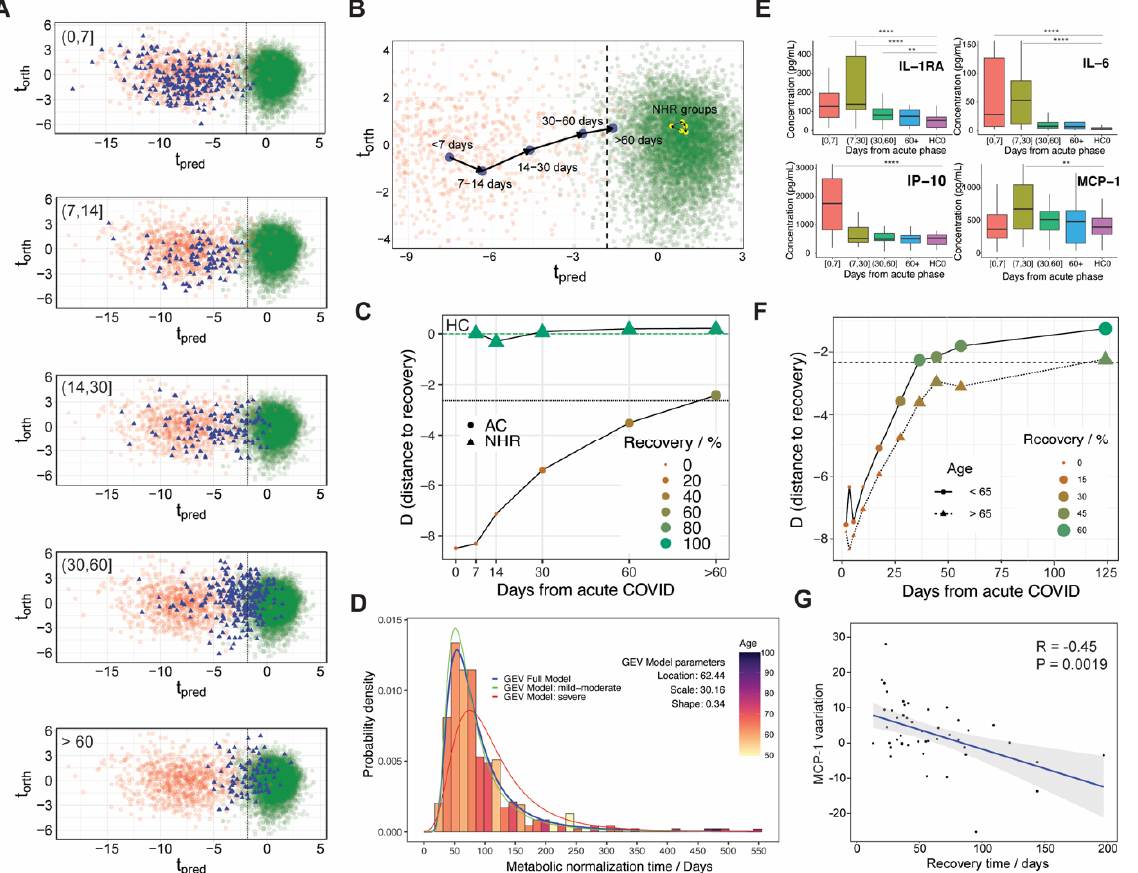
Figure 3. ( A ) Projection of the recovery samples (blue triangles, RE0 and RE1 cohorts) in the O-PLS- DA model that discriminates between COVID-19 patients (red circles, AC0 and AC1 cohorts) and healthy individuals (green circles, HC cohort), as a function of the recovery time for the sample, as indicated in the plots. ( B ) Projection of the recovery trajectory on the O-PLS-DA model of COVID- 19 discrimination for hospitalized patients (blue circles) and non-hospitalized recovered (NHR) (yellow circles). ( C ) distance to recovery (D) as a function of the days from the infection onset for hospitalized patients (circles) and NHR individuals (triangles). The color and the size of the circles or triangles is proportional to the fraction of recovered people at a given time, as indicated in the legend. ( D ) Histogram of the individual recovery times for the metabolic phenotype assuming a linear recovery model. The distribution fits well to a GEV function (blue line), whose fitting param- eters are enclosed. The green and red lines show the same type of model but using only a subset of patients according to the hospital’s severity criteria: mild-moderate (green) or severe (red). The color code for the histogram bars displays the average age, as indicated in the legend. ( E ) Boxplots show- ing the time evolution of serum concentration corresponding to the four cytokines/chemokines that were found significantly upregulated in hospitalized patients. Statistical significance of the differ- ence between the two groups was estimated by the p -value: 0.01 (**) and 0.0001 (****). ( F ) distance to recovery (D) as a function of the days from the infection onset for hospitalized patients as a func- tion of age: people above/below 65 years old are represented by circles/triangles. The color and the size of the circles or triangles are proportional to the fraction of recovered people at a given time, as indicated in the legend. ( G ) Correlation between the variation of MCP-1 over time (assuming a lin- ear decay from day 8) and the individual recovery time (assuming linear recovery). The blue line corresponds to the best linear fit, with the confidence levels depicted in gray.